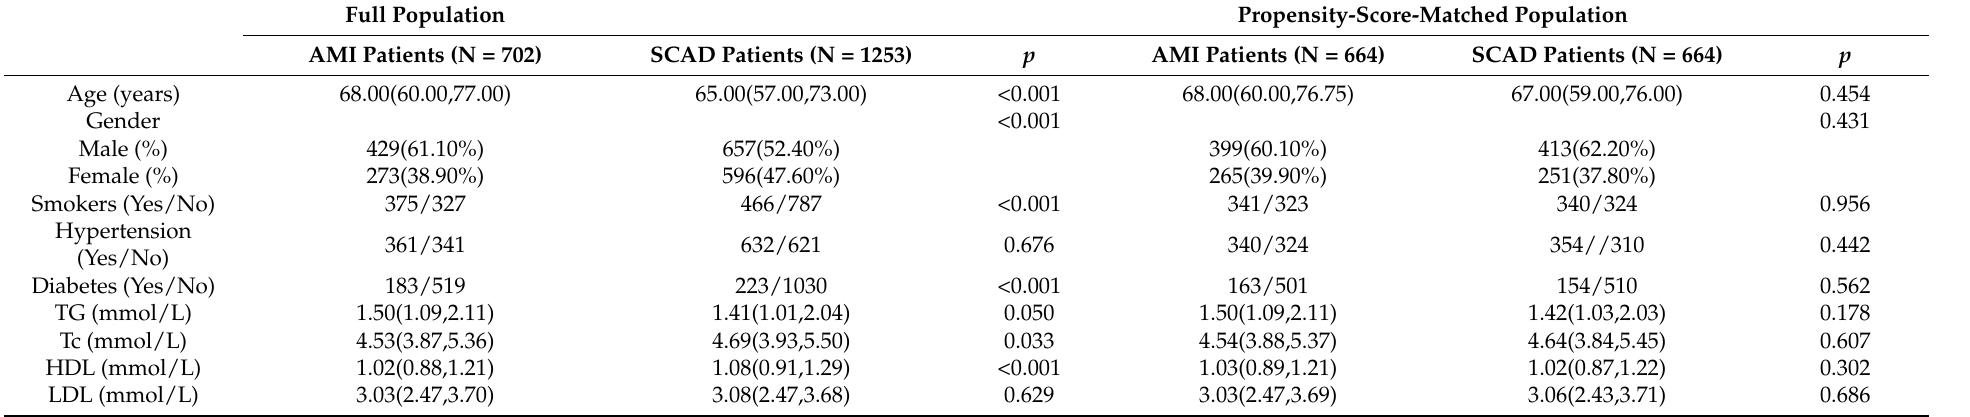
Table 2. Baseline characteristics and AMI—SCAD risk factors in the study